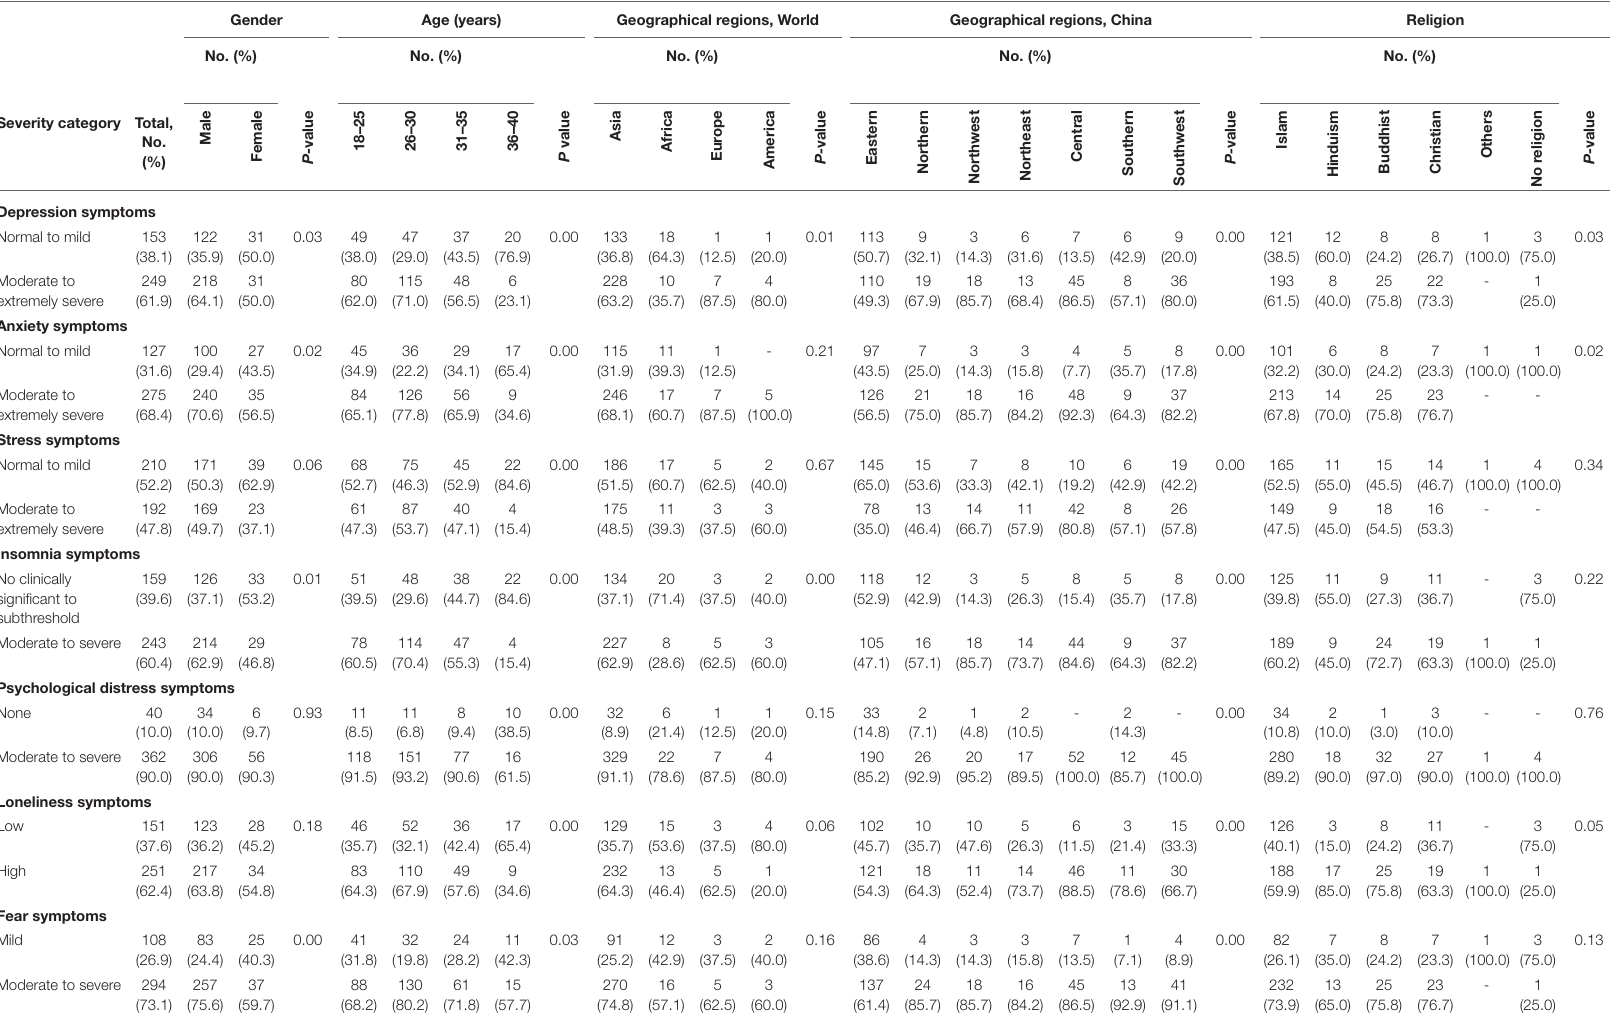
TABLE 2 | Severity categories of depression, anxiety, stress, insomnia, psychological distress, loneliness, and fear measurements in total cohort and subgroups. Gender Age (years) Geographical regions, World Geographical regions, China Religion No. (%) No. (%) No. (%) No. (%) No. (%)